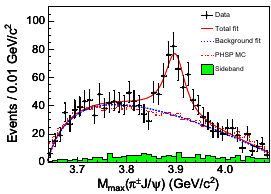
Figure 7. The M max ( π ± J /ψ ) distribution and best fit from